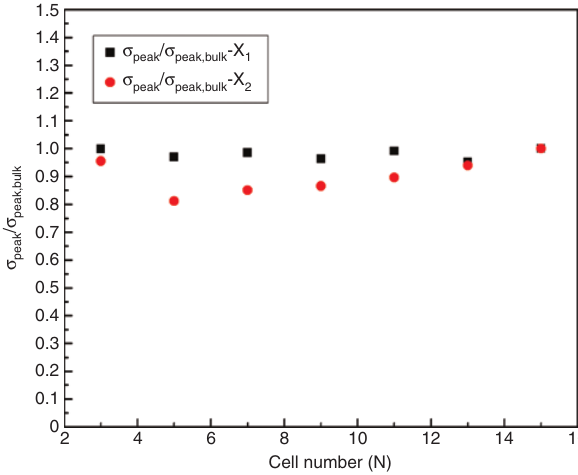
Figure 9 The plateau stress and the densification strain of seven kinds of honeycomb specimens with different in-plane size while compressed in x -direction, normalized by the bulk value, plotted 1 against cell number, N